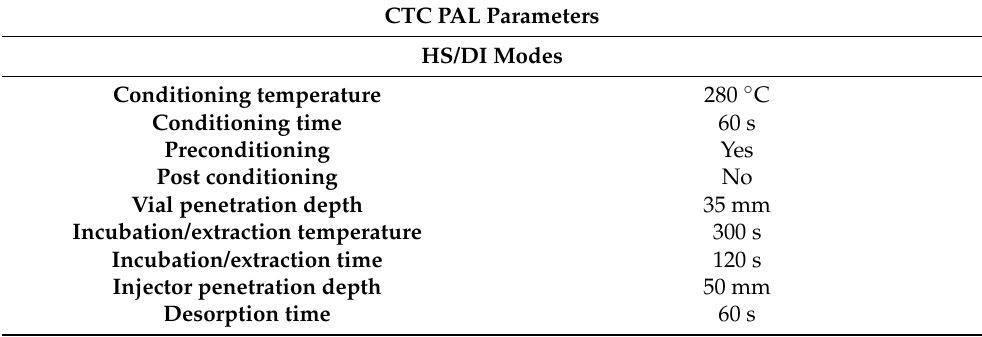
Table 2. HS/DI–SPME parameters.